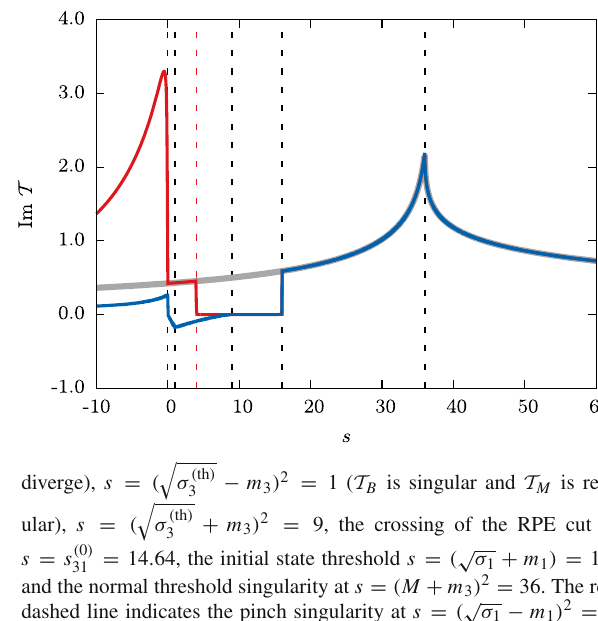
( th ) value greater than the threshold σ close to the real axis. tarity. The B -matrix triangle has noticeable kinks in both 3 the real and imaginary parts below threshold, corresponding to the singularities discussed above. The black dashed lines indicate the location of the singularities. Starting from low energy, the first additional singularity is the s = 0